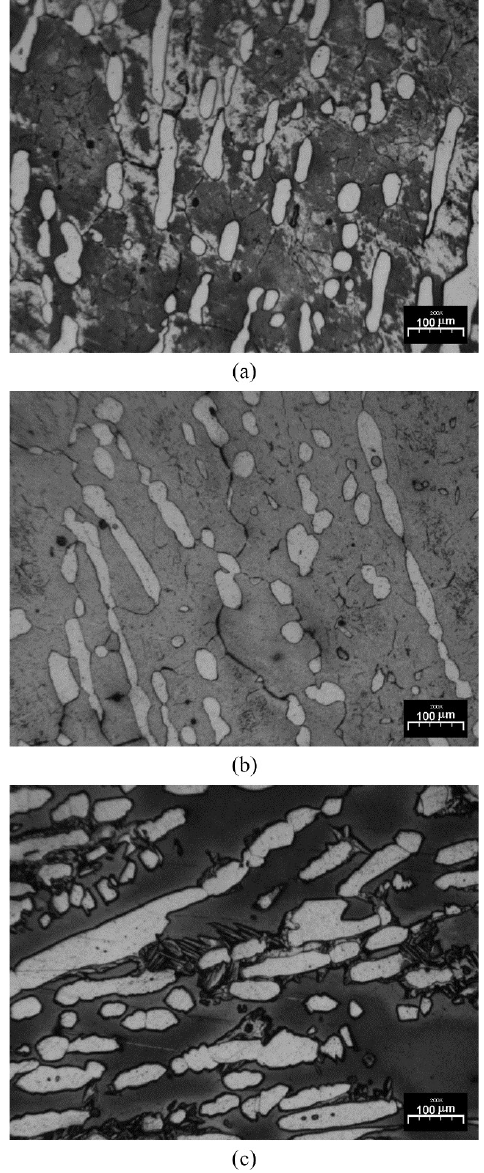
Figure 4. Optical micrographs of the surface aspect of 2205 DSS solution-treated and cooled (a) rapidly (b) moderately and (c) slowly, after DL-EPR